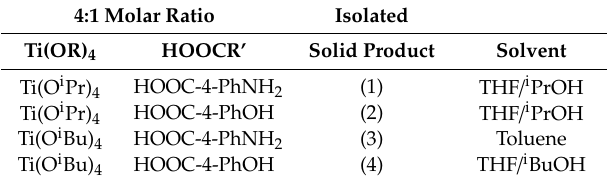
Table 1. The compositions of the reaction mixtures. THF: tetrahydrofuran.